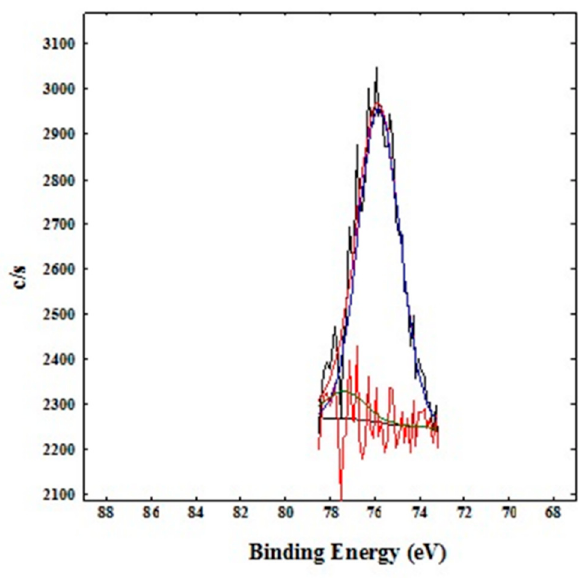
Figure 6. XPS spectrum for the Al2p region for the compound Bi 2 O 2 CO 3 :Al. Table 5. Atomic concentrations and allocations for the Al2 p region for the compound Bi 2 O 2 CO 3 :Al. Bond Energy for Al2 p (eV) % by Type of Al2 p Assignation 75.8 92.11